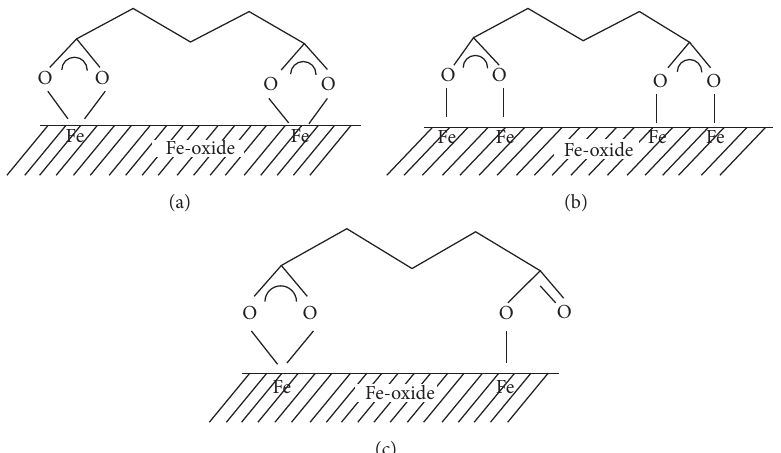
Figure 9: Schematic representation of possible modes of binding of glutarate with the passive film: (a) bidentate chelating at both ends, (b) bidentate bridging at both ends, and (c) bidentate